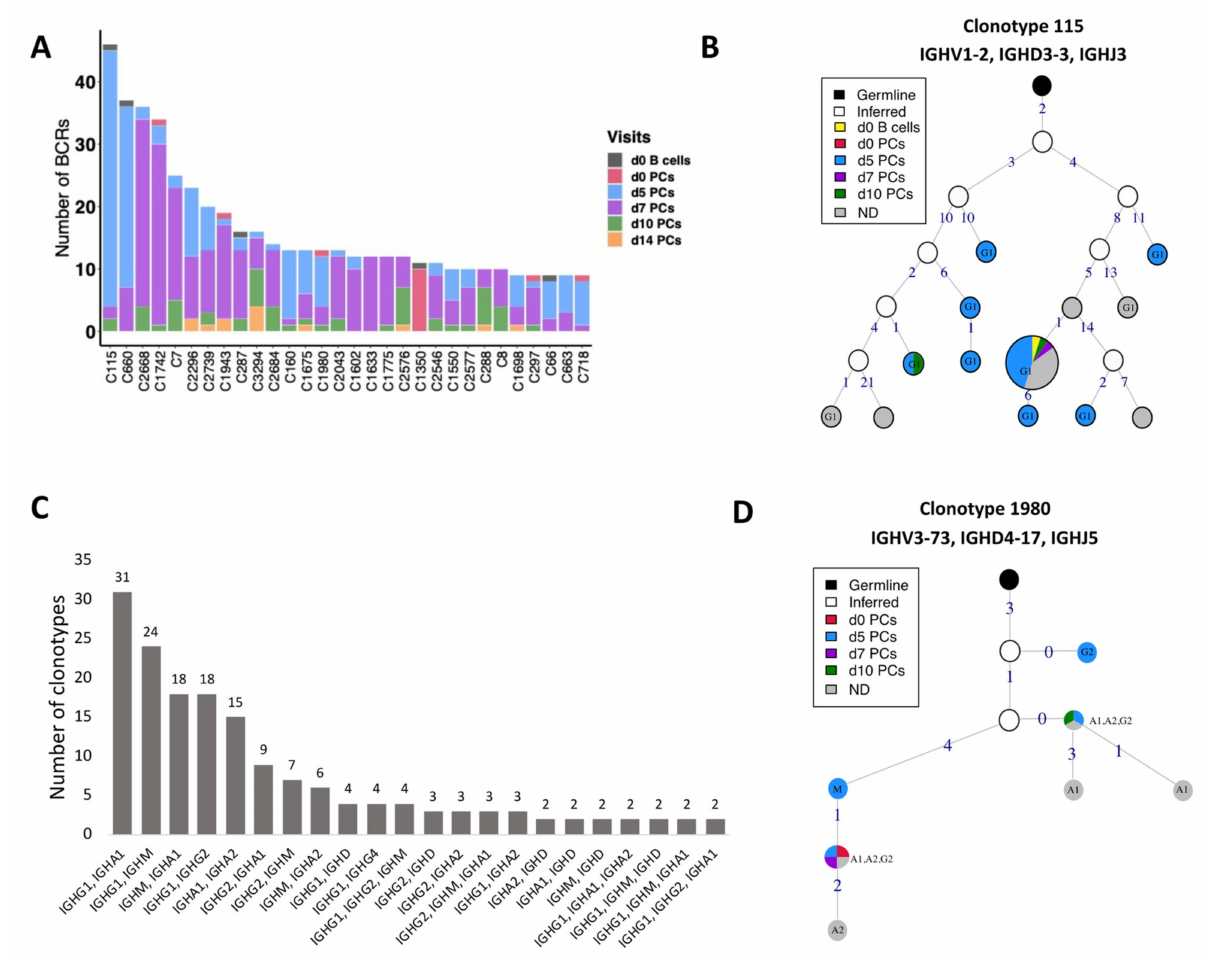
Figure 5. BCR clonotypes over different time-points. ( A ) 30 most numerous clonotypes over different time-points pre- and post-vaccination. Contribution of different visits to the total size of a clone is indicated by colors. ( B ) Clonal lineage of clonotype 115. The graph is constructed using V gene germline sequence as the root node. The size of each node is scaled and directly related to the number of BCRs for that particular sequence. The nodes are colored based on the visits from which sequences are derived. The unique sequences present across multiple visits are also grouped and colored differently as mentioned in the legend. Germline is colored black and the inferred nodes are colored white. The edge label indicates the number of different nucleotides as compared to the previous node. ( C ) A bar plot indicating the >2 clonotypes containing cells with multiple constant genes. For example; each of 31 clonotypes consist of sequences using IGHG1 and IGHA1 constant genes. The number of clonotypes for each combination is mentioned on the top of bar. ( D ) Clonal lineage of clonotype 1980 with class-switch recombination events. Additional inferred nodes were added to correctly represent the order of